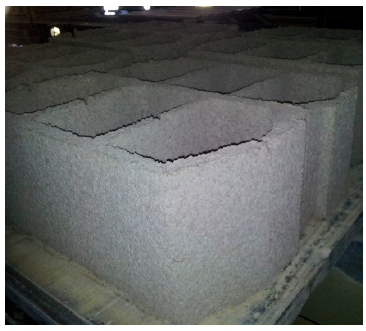
Figure 3. Hollow block manufacturing.